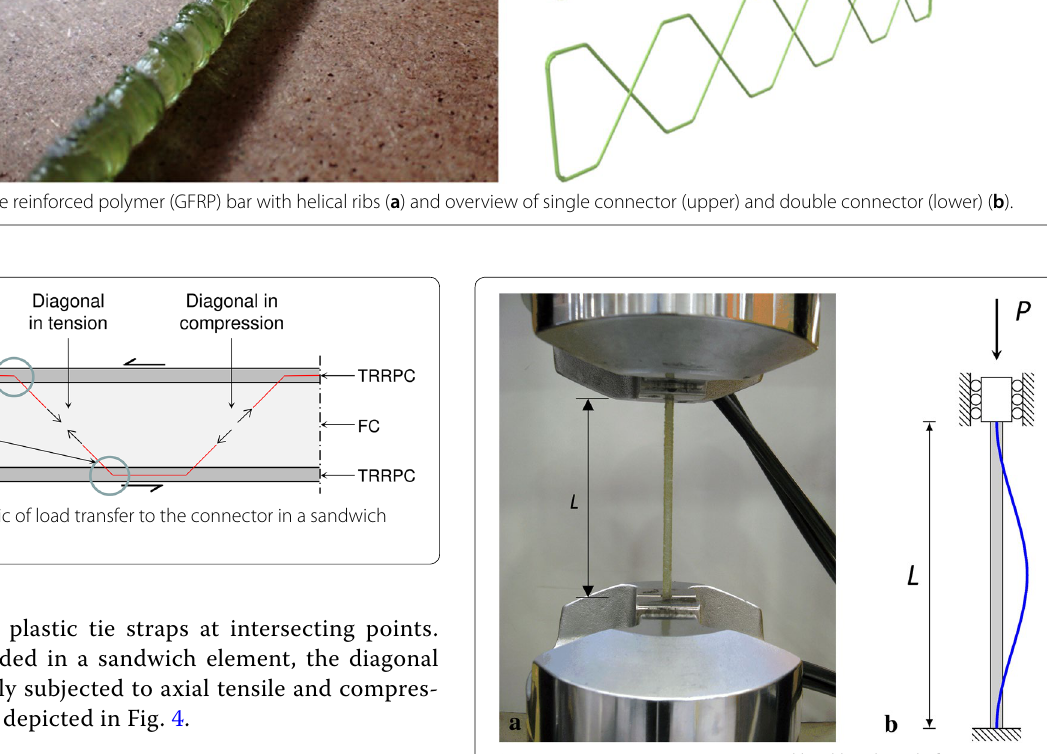
Fig. 5 Compression test setup ( a ) and buckling length ( b